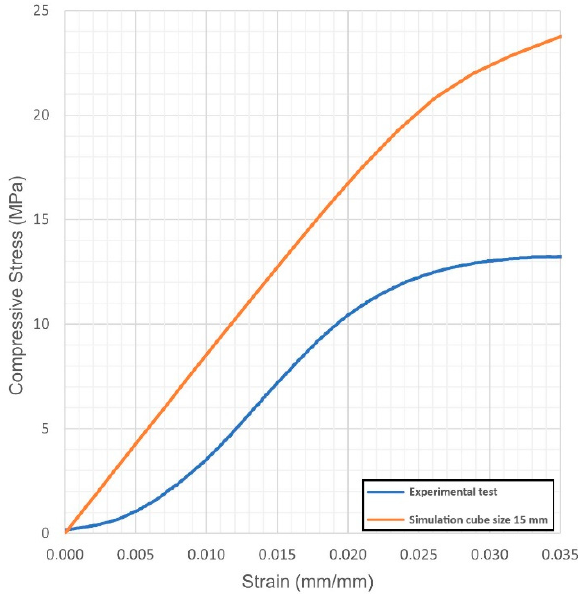
Figure 8. Condition 3, stress-strain diagram; comparisons between simulated and actual spec- imens.